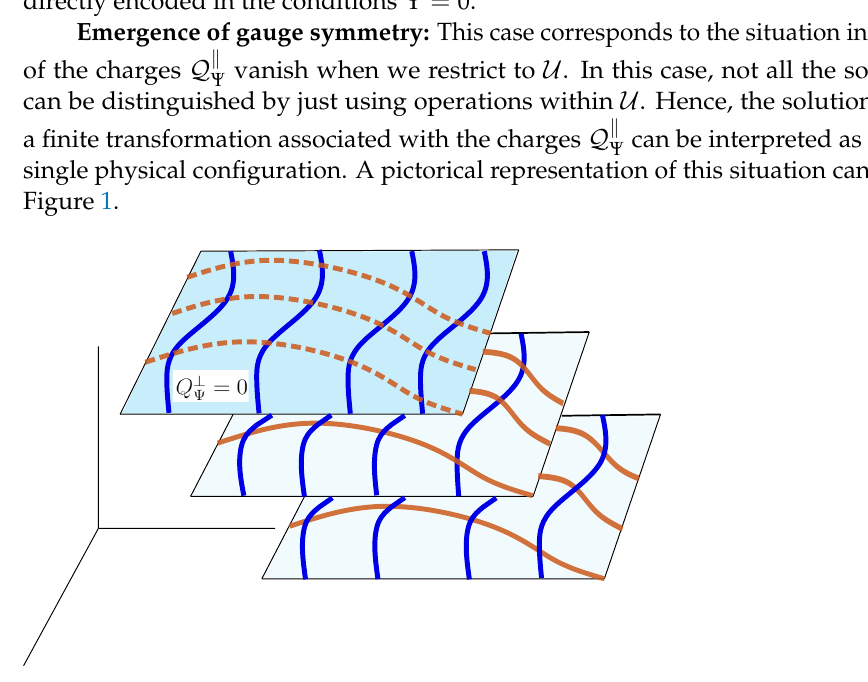
Figure 1. We represent the space of solutions S and the set of surfaces characterized by constant values of Q ⊥ Ψ . Among them, there is a privileged one represented in darker blue characterized by Q ⊥ Ψ = 0, i.e., it represents the subspace U from the discussion above. The solid blue and brown curves (cid:107) ⊥ represent curves of constant Q Ψ = constant. The dashed brown curves Ψ within the surfaces of Q within the subspace U represent the emergent gauge orbits, i.e., they connect points that cannot be distinguished by performing operations within U and are characterized by the same vanishing value (cid:107) of some of the charges Q Ψ in U